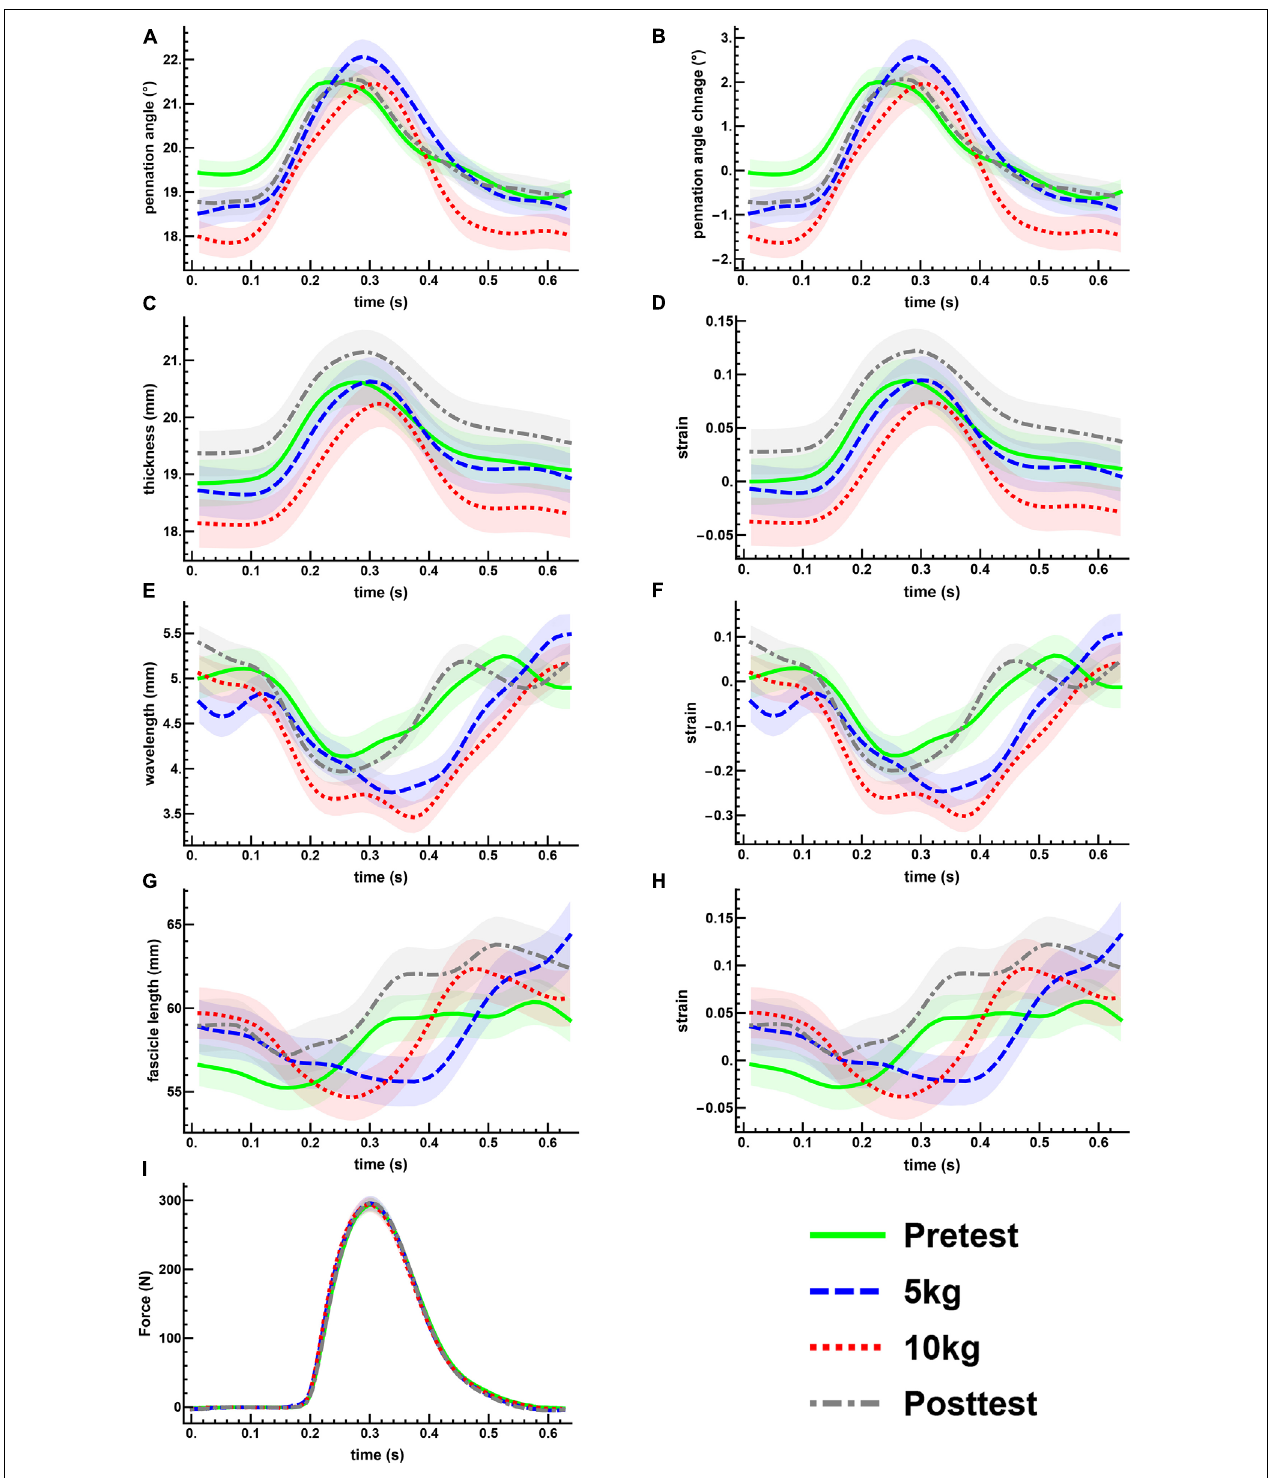
FIGURE 3 | The mean changes in muscle architecture and force measured during muscle twitches. The mean and standard error for all measured twitches are plotted for the pre- (green, solid) and post-test (gray, dot-dashed), and the 5 kg (blue, dashed) and 10 kg (red, dotted) loaded trials. Transient increases are shown for the pennation angle (A,B) and muscle thickness (C,D) . The transverse wavelength (E,F) and fascicle length (G,H) show transient decreases. The measured twitch force (I) shows an increase with muscle activation.